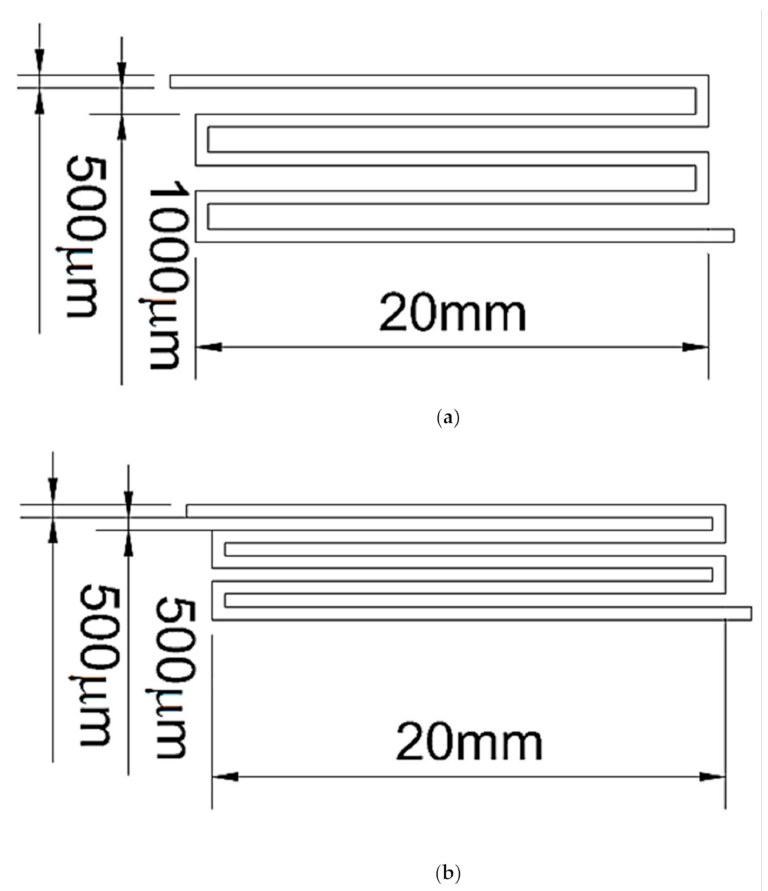
Figure 1. Schematics of the LED chip with a microfluidic channel: ( a ) distance between the channel d = 1 mm; ( b ) distance between the channel d = 0.5